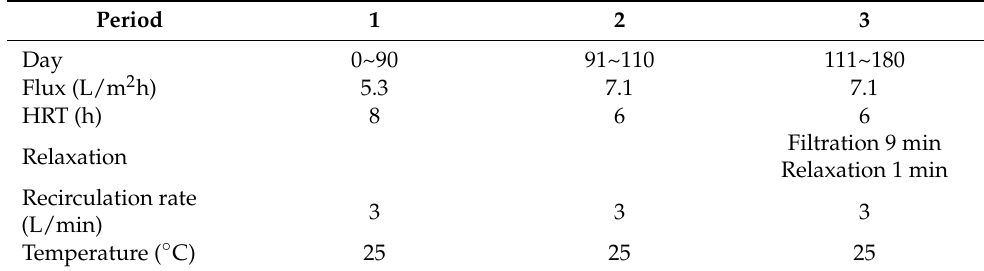
Table 2. Operational conditions of